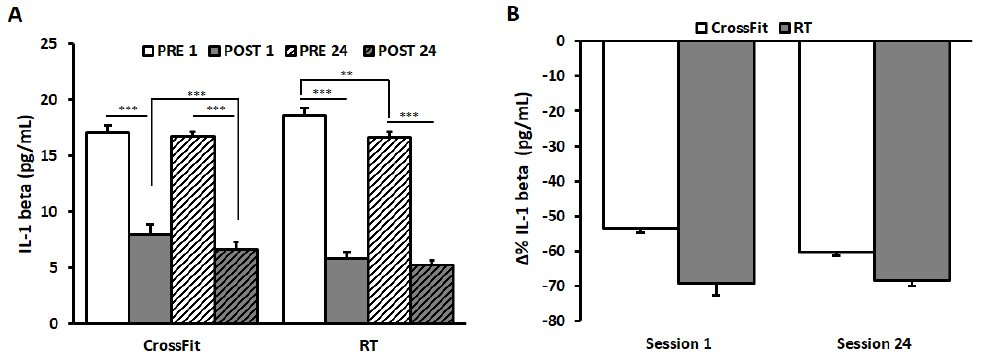
Figure 3. IL-1 β values and ∆ %IL-1 β . IL-1 β values (panel ( A )) of CrossFit ® group (left) and RT group (right), measured before (PRE) and after (POST) the first training session (PRE 1, POST 1) and the last training session (PRE 24, POST 24). ∆ %IL-1 β (panel ( B )) of CrossFit ® group (left) and RT group (right) after the first training session (SESSION 1) and the last training session (SESSION 24). Data are presented as means ± standard error. ** p < 0.01; *** p < 0.001.